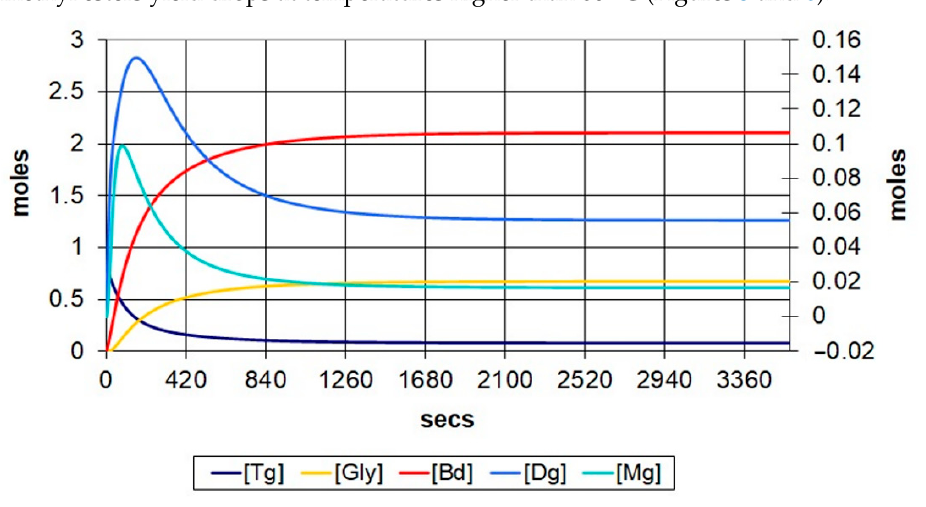
◦ C and 6:1 molar ratio.